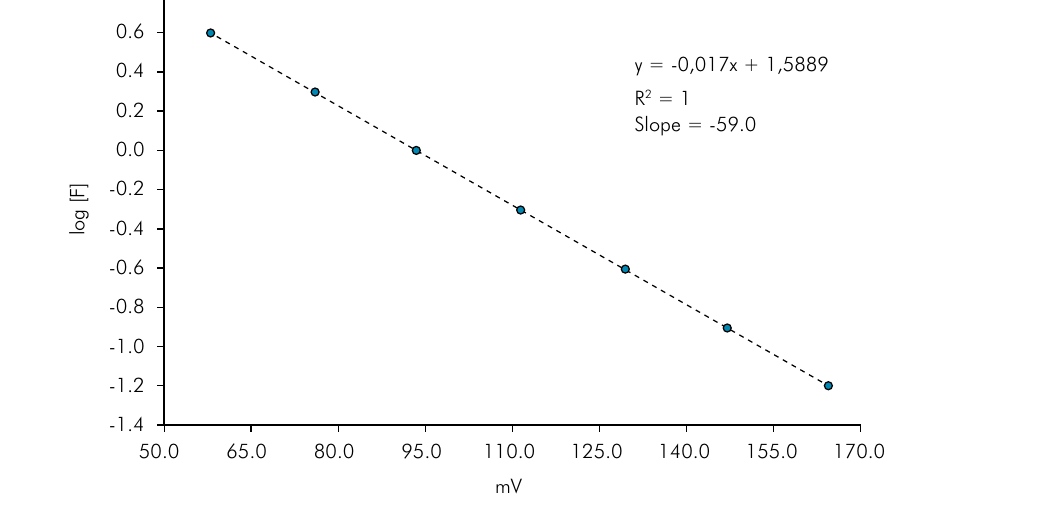
Figure 1. Calibration curve (n = 4) and data on the correlation between the logarithm of fluoride concentrations in the standard and relative mV values